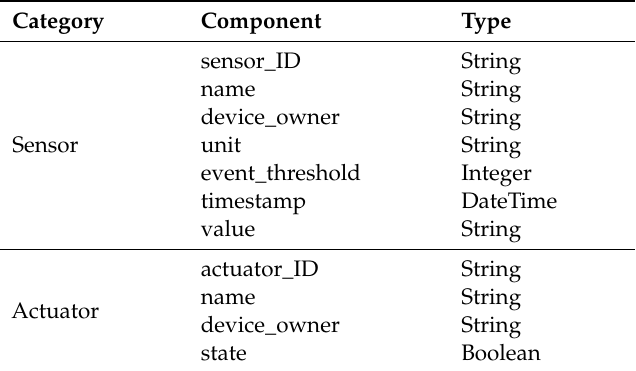
Table 4. Device asset definition in the smart contract.